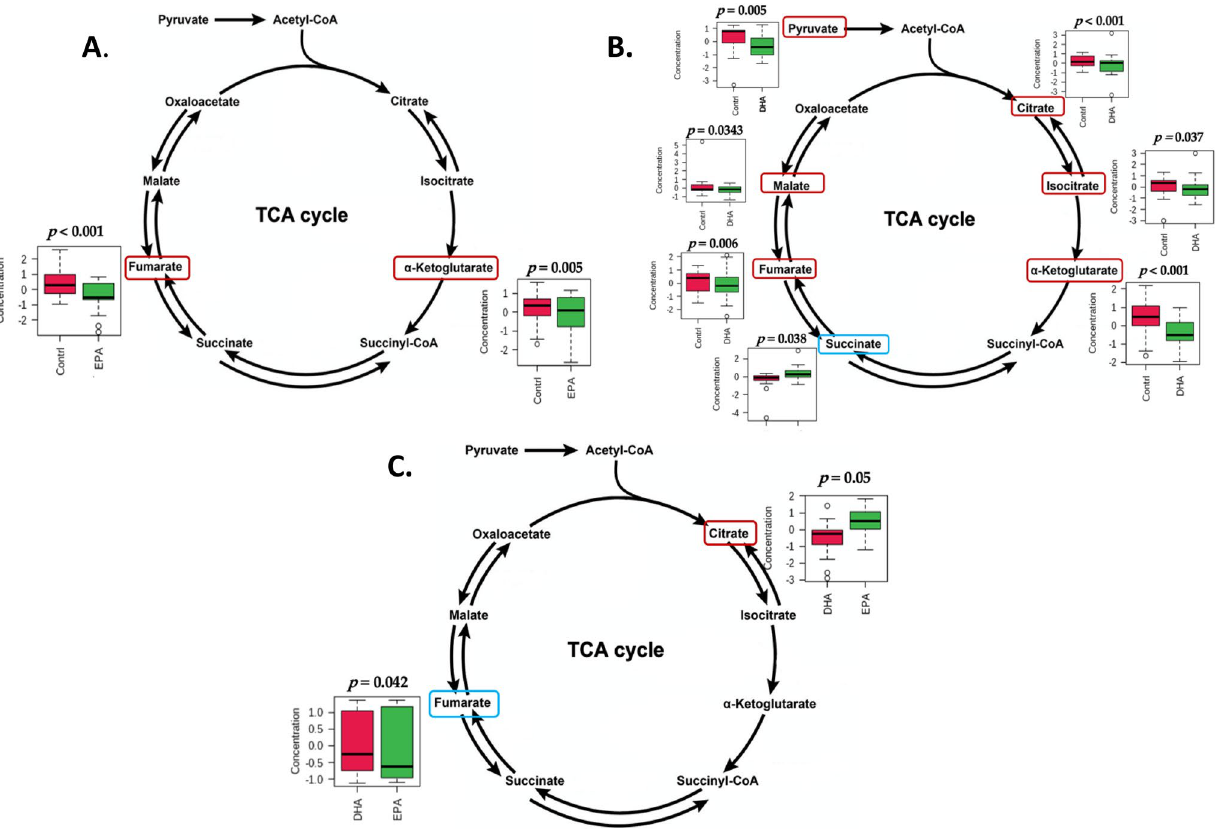
Figure 4. EPA and DHA modulation of TCA cycle metabolites. Significantly increased and decreased metabolites are circled in blue and red, respectively. ( a ) baseline versus EPA supplementation; ( b ) baseline versus DHA supplementation; ( c ) EPA versus